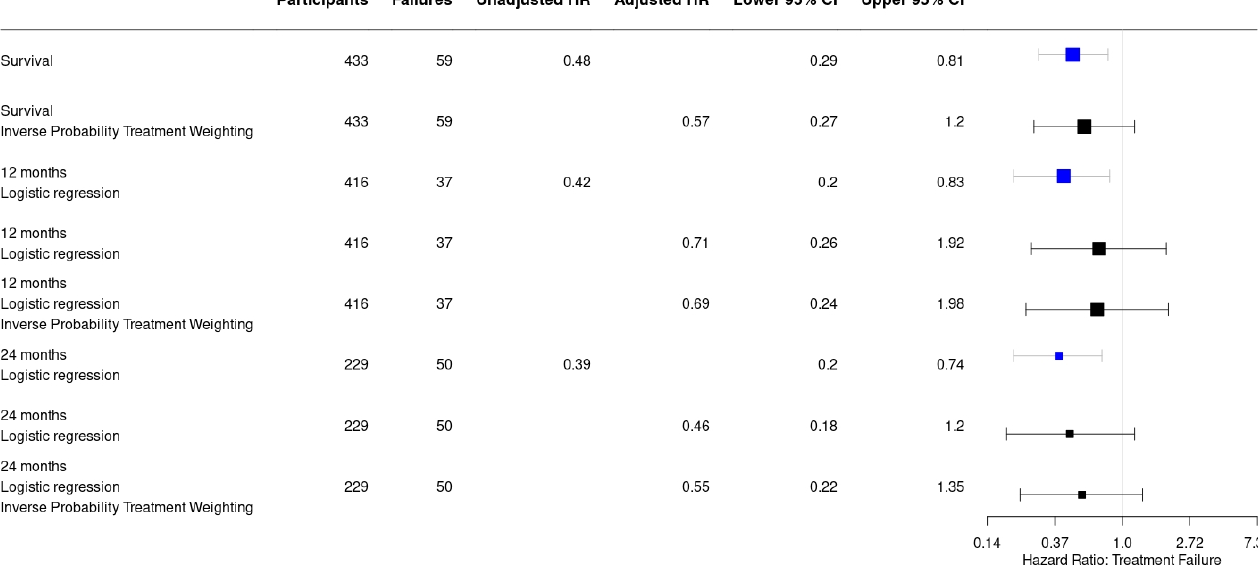
Figure 3. Forest plot displaying a consistent reduction in hazard risk ratios comparing the use of antibiotic-loaded carriers to no antibiotic-loaded carriers, stratified by the analysis performed. Point estimates are given with their 95% confidence intervals. Survival: infection free follow-up; failures: recurrence of infection.